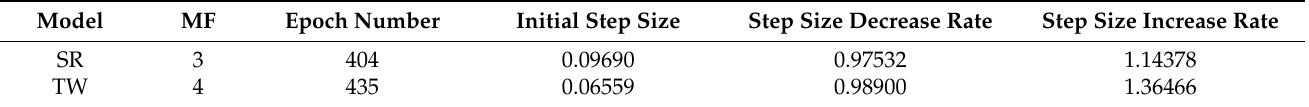
Table 2. Hyperparameters of ANFIS for surface roughness and tool wear